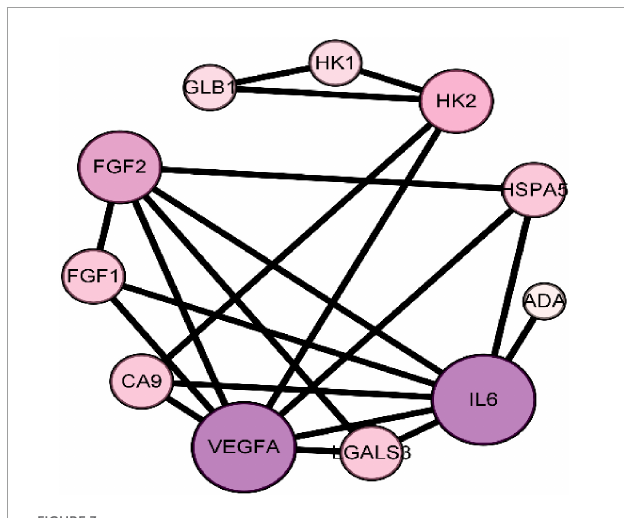
FIGURE3 Protein-protein interaction PPI network of core target of seabuckthorn polysaccharides for prevention and treatment of cervical